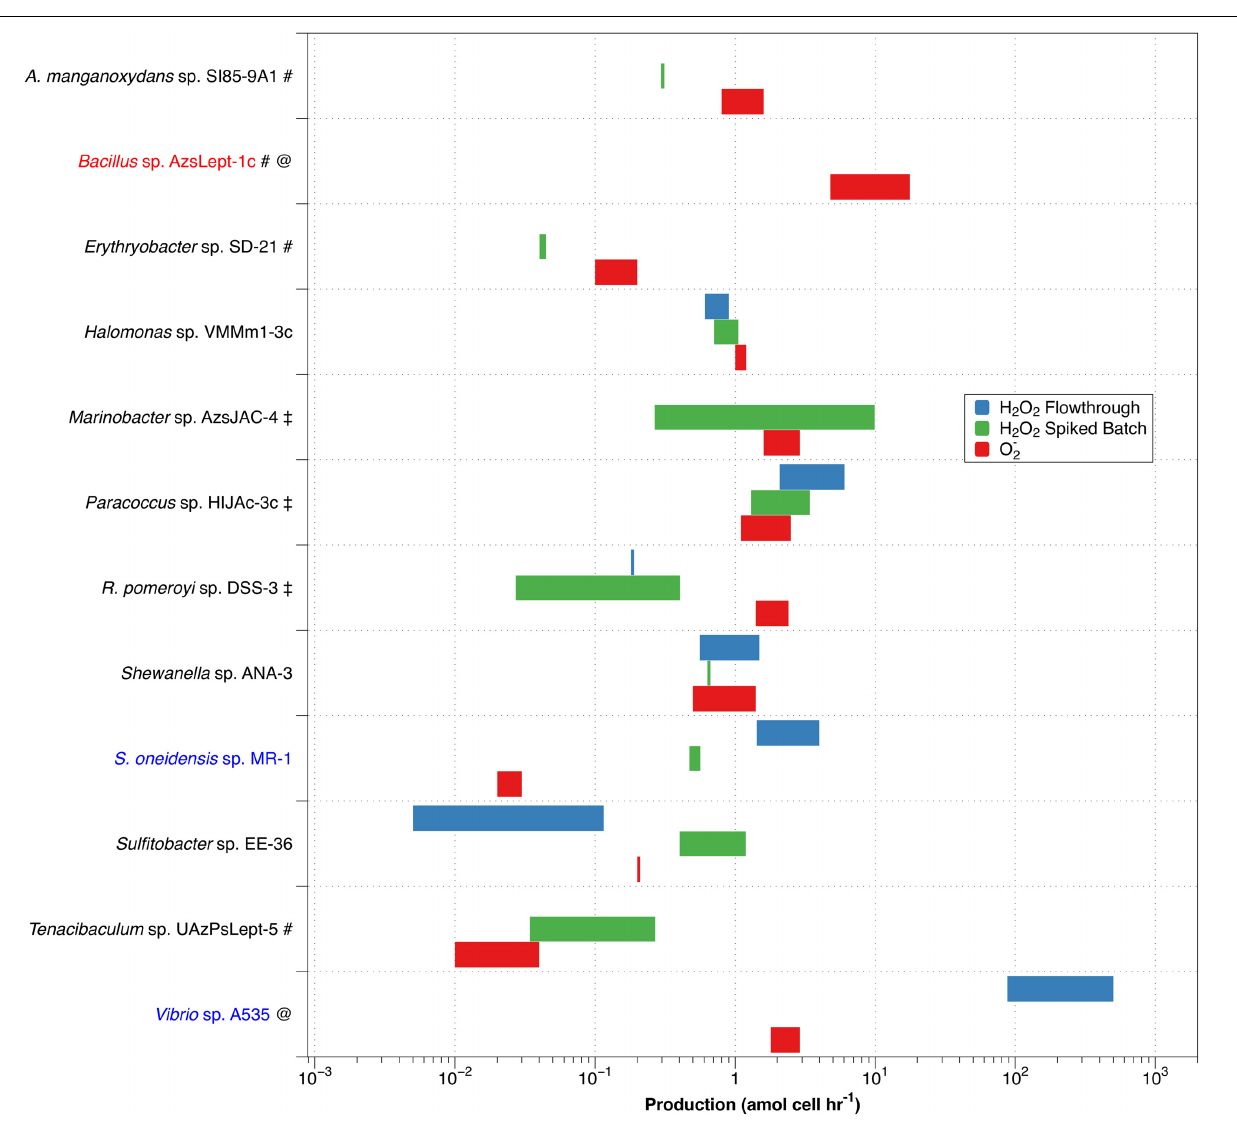
FIGURE 4 | Comparison of non-zero values for P H2O2 , cell (green – spiked batch incubation; blue – flow through) with P O2-, cell (red). Along the y -axis, red text indicates a species that produces more O 2 − than H 2 O 2 , while blue text indicates higher production of H 2 O 2 than of O 2 − . A pound (#) adjacent to the name indicates a species only evaluated by spiked batch incubation; @ indicates no non-zero P H2O2 values were observed for spiked batch incubations; while a double dagger ( ‡ ) indicates that negative production was observed for at least some values in the flow-through